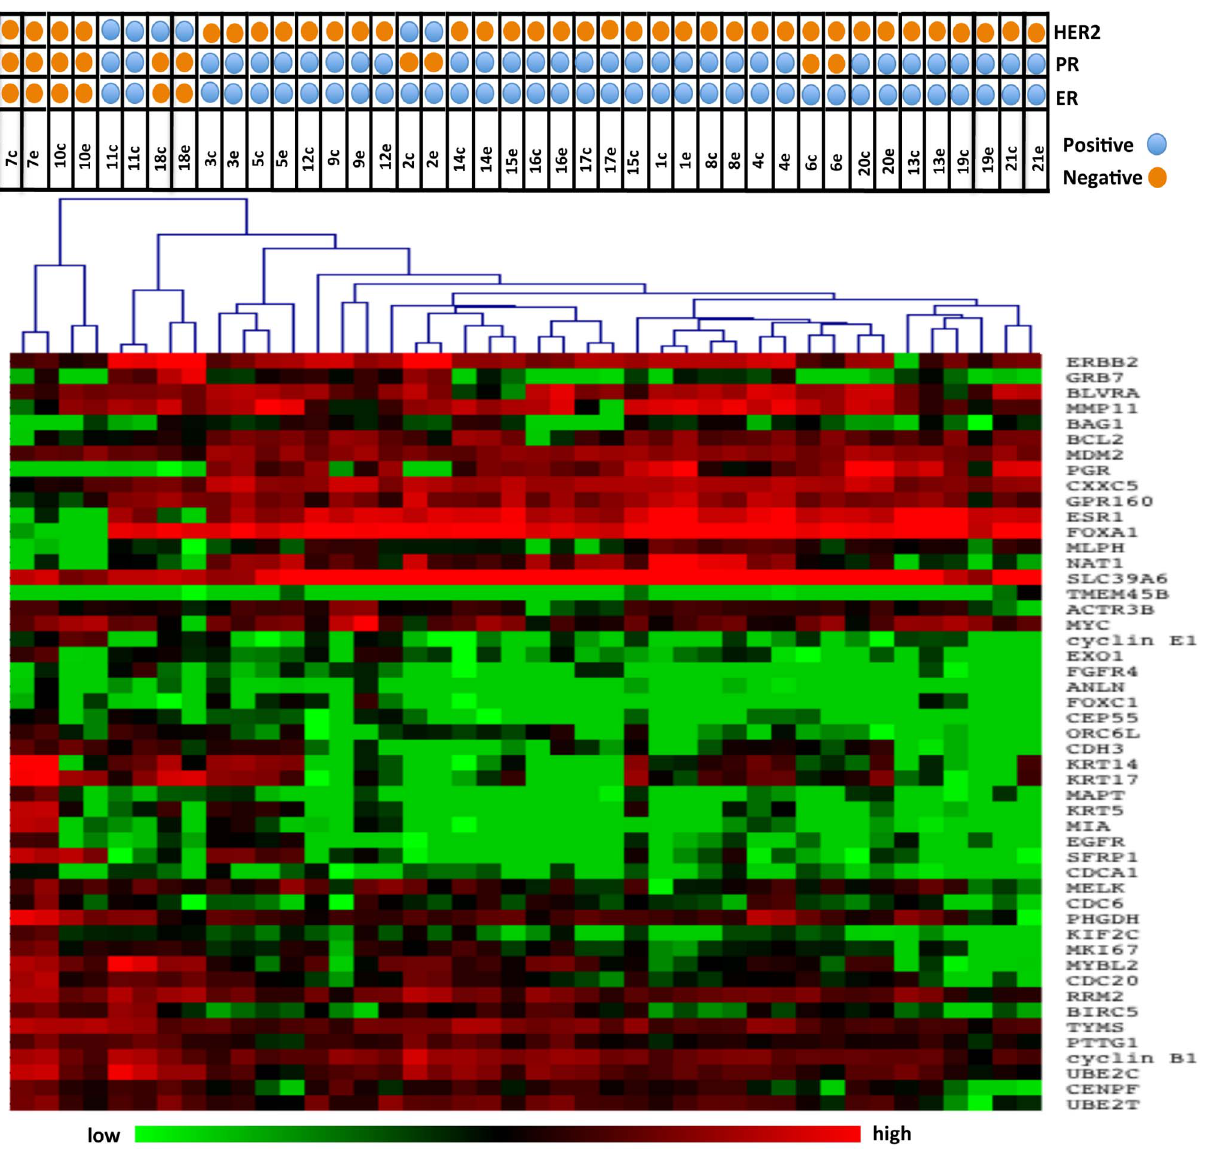
Figure 4. Heatmap of unsupervised clustering of the CNB and EBS using the PAM50 genes. Unsupervised clustering heatmap of all samples using the PAM50 genes only. 19 of the 21 paired biopsies co-aggregated in the first level